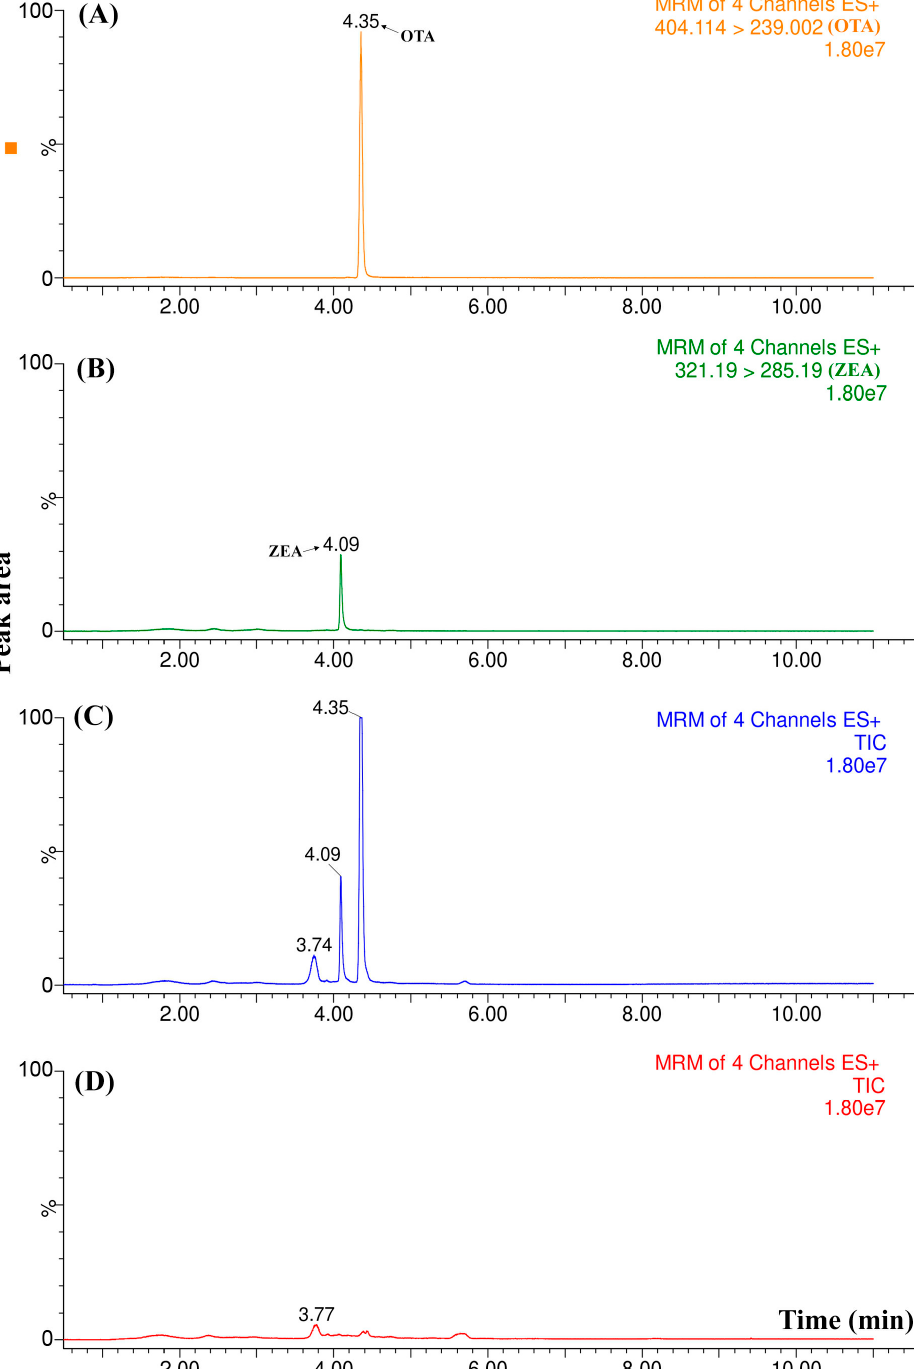
Figure4. Representativechromatogramscomparingablankwinesamplewithonespikedataconcentration Figure 4. Representative chromatograms comparing a blank wine sample with one spiked at a of at 15 µ g L − 1 . ( A ) OTA ion transition; ( B ) ZEA ion transition; ( C ) total ion chromatogram of the concentration of at 15 µg L − 1 . ( A ) OTA ion transition; ( B ) ZEA ion transition; ( C ) total ion spiked wine; and ( D ) total ion chromatogram of the blank wine chromatogram of the spiked wine; and ( D ) total ion chromatogram of the blank wine sample.